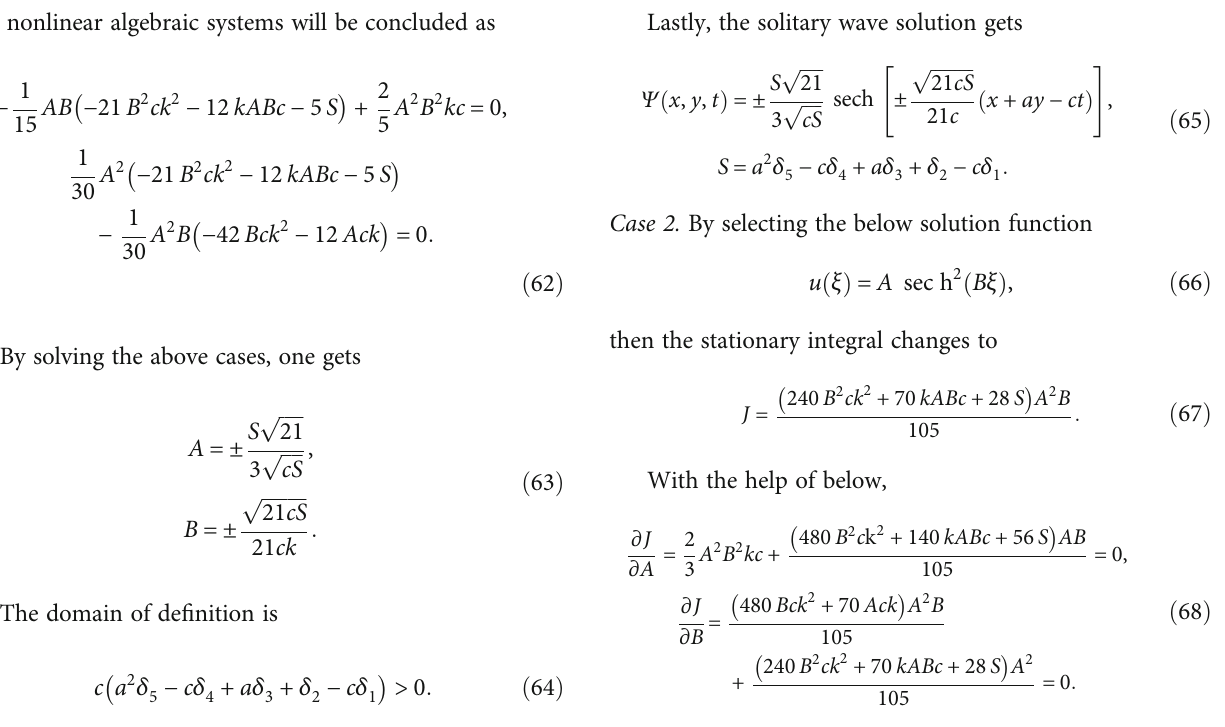
Figure 8: Plot evolution of cross-kink waves (37) utilizing values a = 2, δ = 1 : 3, δ = 2, Ψ = 1, t = 10 and (a) 3D plot, (b) density plot, and (c) contour δ 3 4 5 0